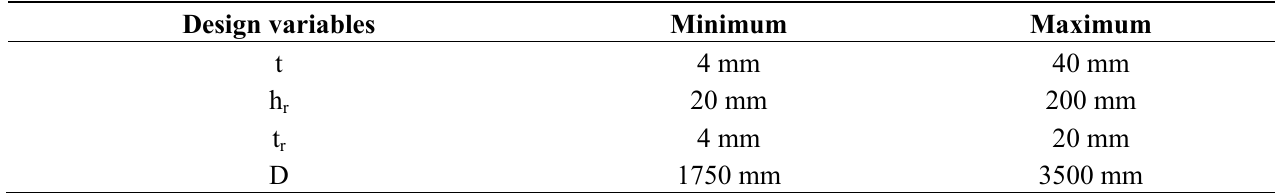
Table 2. Minimum and maximum values of the design variables.